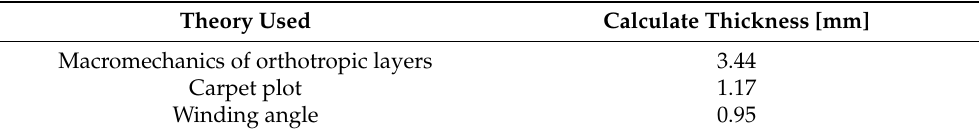
Table 10. Cylinder thickness estimated from three